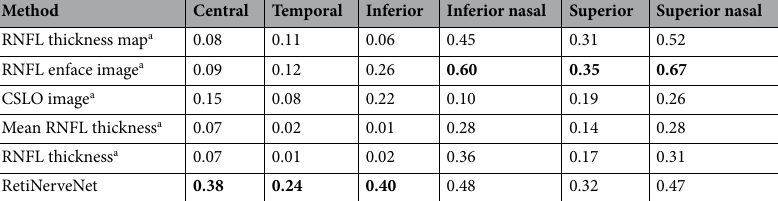
2 Table 4. R values for sectoral mean pattern deviation estimation. Best results in boldface. CSLO: confocal scanning laser ophthalmoscopy. a Quoted from Christopher et al. 14